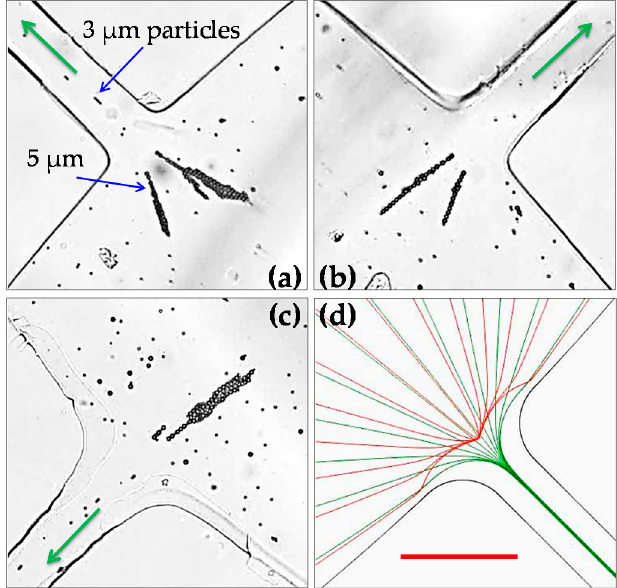
Figure 4. Electrokinetic concentration and separation of 5- μ m-diameter polystyrene particles from 3- μ m polystyrene particles at different central reservoir-microchannel junctions of the stacked microfluidic device under a 50-V DC-biased 500-V AC voltage: ( a ) snapshot image in Layer A (see Figure 1); ( b ) snapshot image in Layer B; ( c ) snapshot image at a different reservoir-microchannel junction of Layer A; and ( d ) numerically predicted trajectories at any reservoir-microchannel junction. The arrows indicate the fluid and particle moving directions during the separation. The scale bar represents 100 μ m and applies to all images.